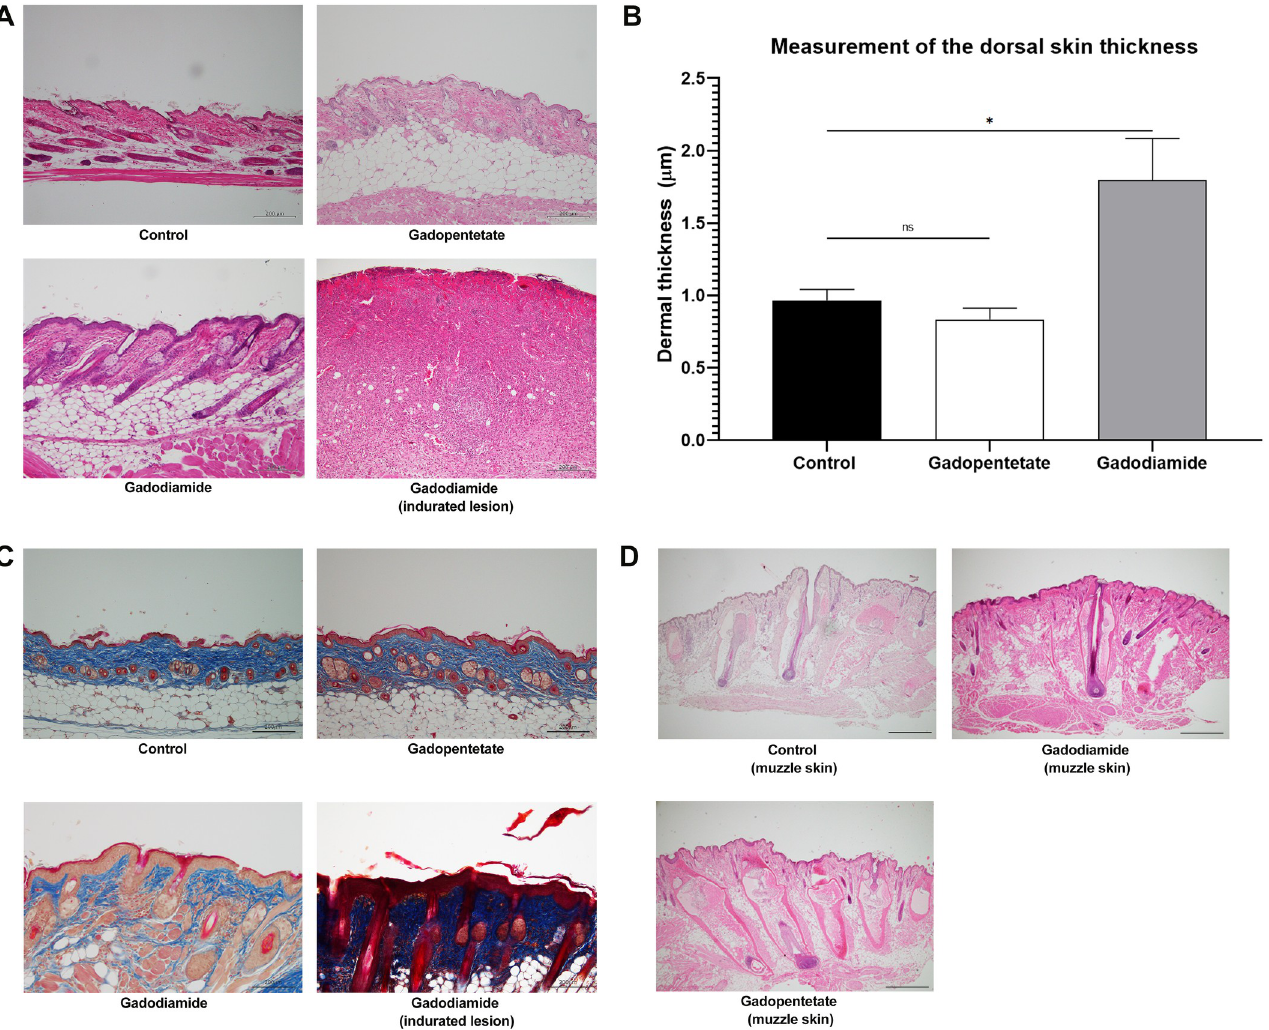
Fig 2. Skin alteration after gadolinium injection. Representative photomicrographs of haematoxylin and eosin staining (A) or Masson’s trichrome staining (C) show effects of different GBCA injections on the skin. Scale bar = 200 μ m. Quantification of epidermal thickness in mice after receiving gadolinium injection (B). The dermal thickness in the gadopentetate group and gadodiamide group with mild lesions were similar to the control group, while mice with severe lesion had thicker dermis. Representative photomicrographs of haematoxylin and eosin staining (D) taken from the muzzle area show destroyed dermal papilla after the injection of gadopentetate. Picture on the lower right (D) is a 10x magnification of gadopentetate-injected muzzle skin. Scale bar = 200 μ m. All data represent the mean score ± SEM. ns = not significant �� p < 0.01.